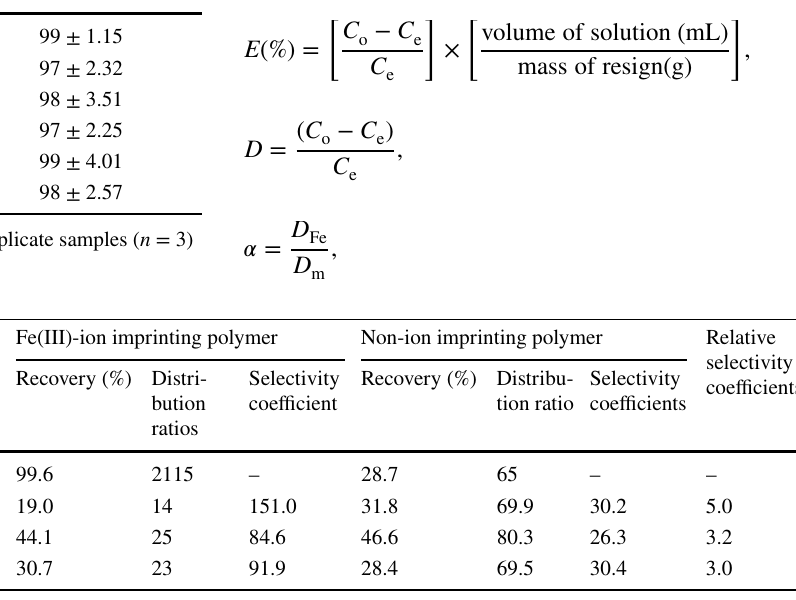
Table 5 The effect of foreign ions on the retention of 0.1 mg of Fe(III), pH 2.5